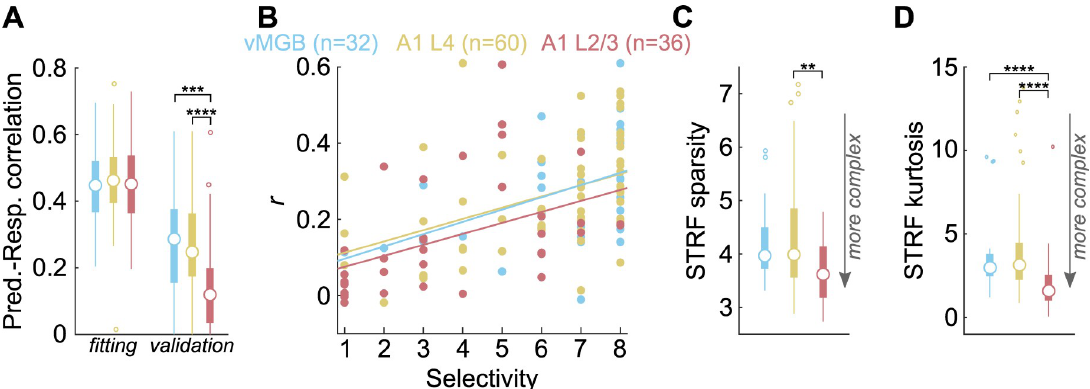
Fig 7. Performance and complexity of STRF estimates across processing stages. (A) Performance of LN models on test and validation data from MGB (blue), A1 L4 (yellow), and A1 L2/3 (red). Discs denote medians, thick lines denote interquartile range, and thin lines correspond to the extent of the distribution. Outliers are shown as dots. (B) Model validation performance plotted as a function of call selectivity across processing stages. Dots are individual neurons, and lines correspond to linear fit. (C) Distributions of STRF sparsity across processing stages. Colors and symbols as earlier. (D) Distributions of STRF kurtosis across processing stages. Colors and symbols as earlier. For all panels except B, Kruskal–Wallis tests with post hoc Dunn–Sidak tests were used for statistical comparisons. For B, an ANCOVA with selectivity as a covariate was used. Asterisks correspond to: � p < 0.05, �� p < 0.01, ��� p < 0.005, ���� p < 0.001 (exact p - values in main text). Data underlying this figure can be found in Supporting information file S7 Data. LN, linear–nonlinear; STRF, spectrotemporal receptive